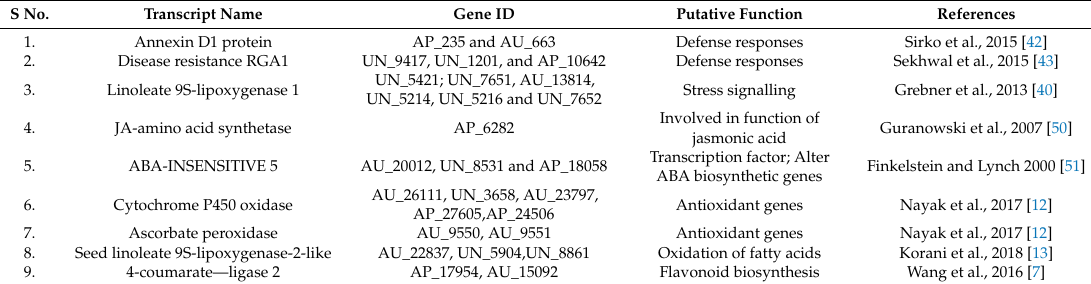
Table 4. Di ff erentially expressed key transcripts and their putative